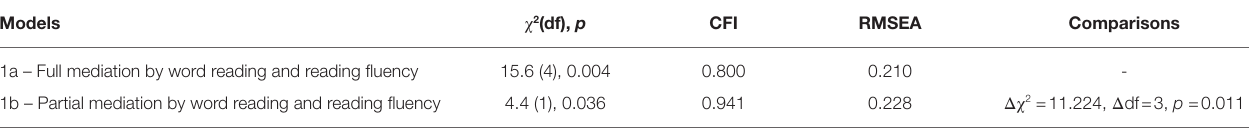
TABLE 4 | Goodness-of-fit indexes for the mediation models and comparison between full and partial mediation models.